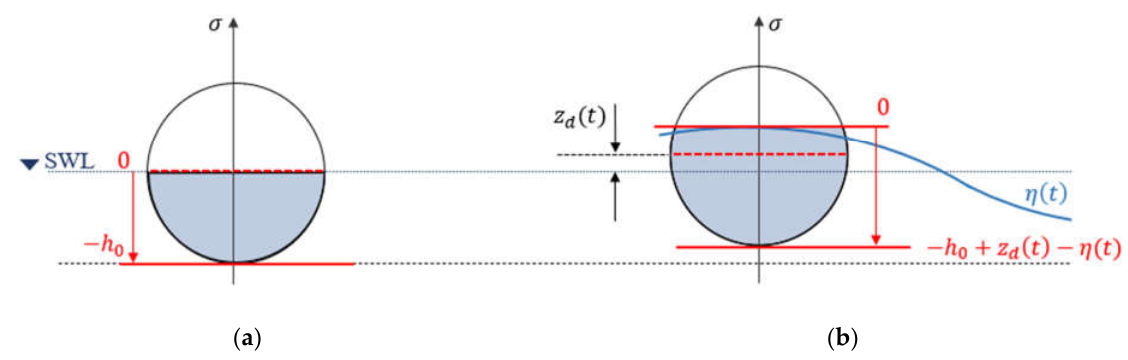
Figure 2. Heaving spherical point absorber at the still water level (SWL) on the left ( a ); to the right ( b ) is shown the displacement from resting position z d ( t ) and the wave elevation η ( t )